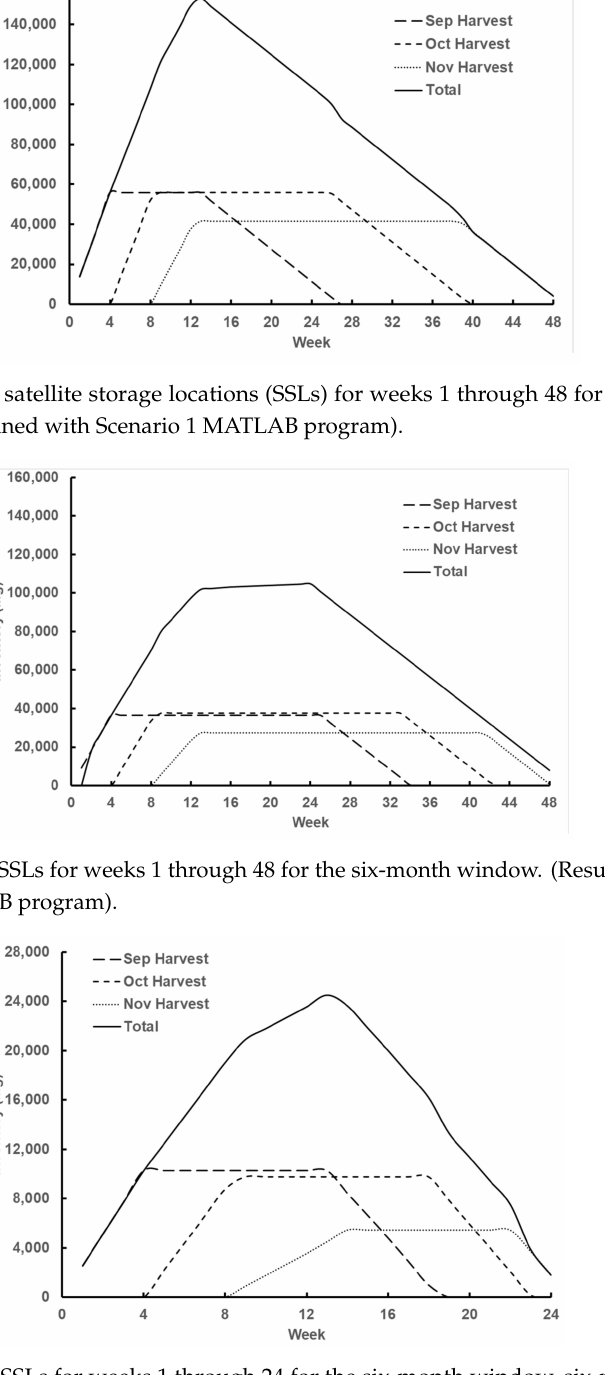
Figure 7. Inventory in SSLs for weeks 1 through 24 for the six-month window, six-month campaign. (Results obtained with the Scenario 3 MATLAB